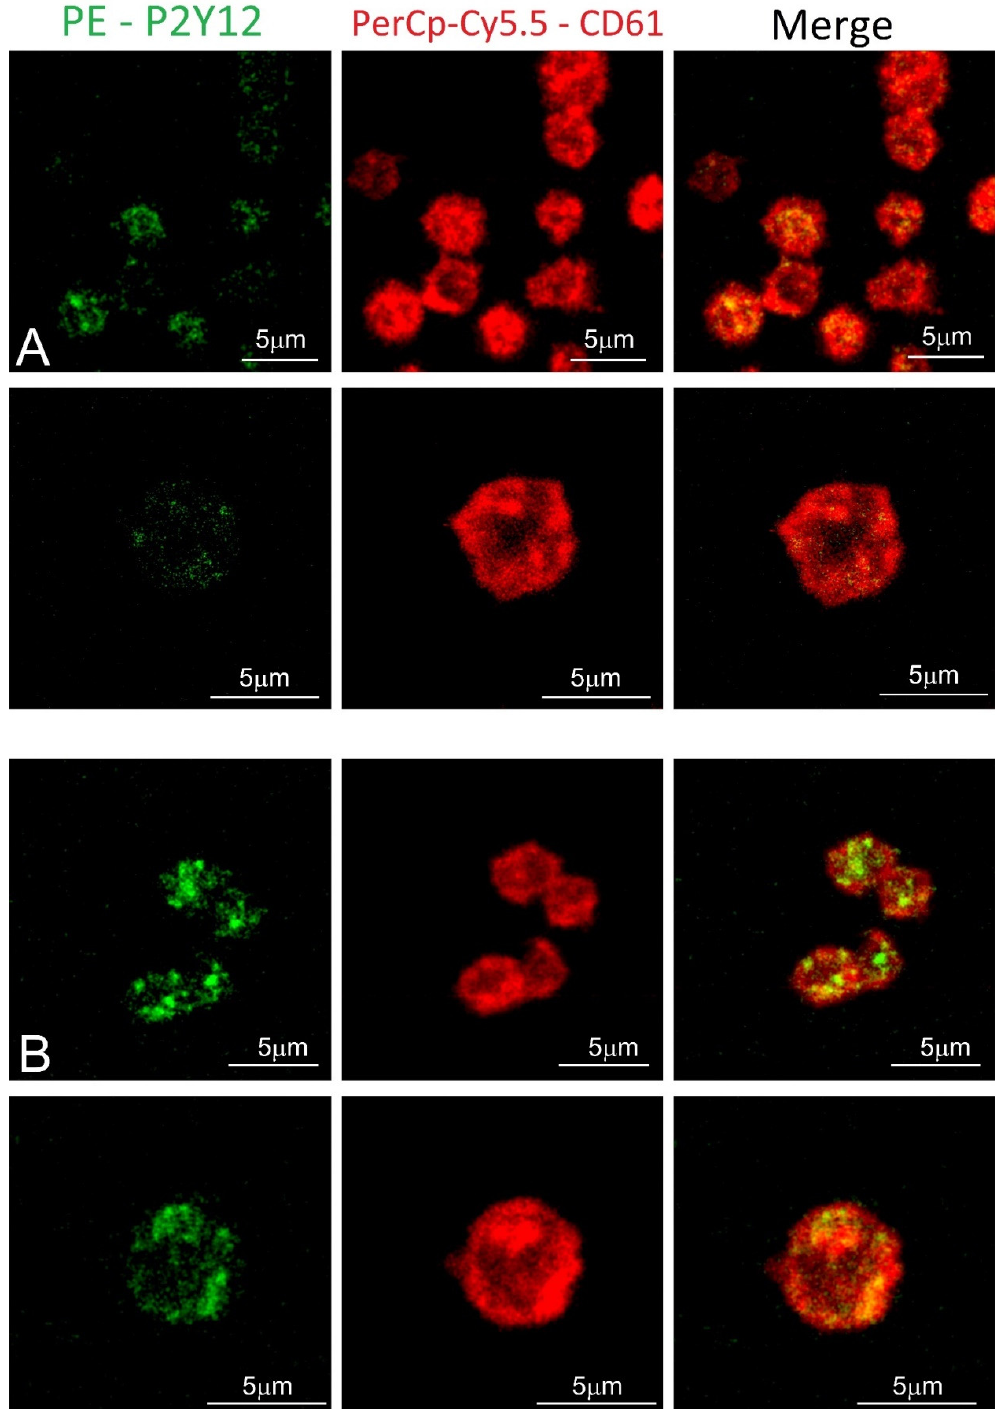
Figure 4. Confocal microscopy of fixed platelets. Samples were labeled with the platelet marker CD61-PerCP-Cy5.5 and with P2Y12-PE. Control and study platelets were deposited on the glass slides with CyGEL™. ( A ) blood platelets obtained from control donor; ( B ) blood platelets obtained from ACS